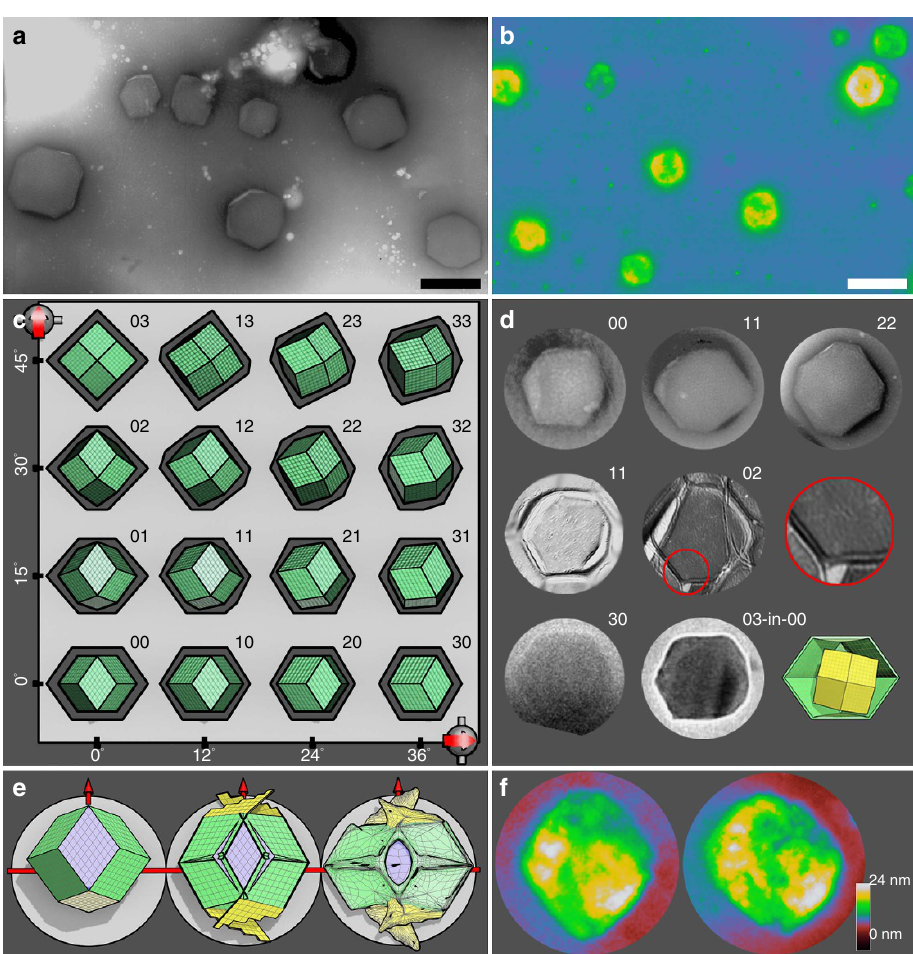
Figure 3 | Morphology of the SDS@2 b -CD polyhedra. ( a ) A TEM picture of the negatively stained polyhedra, scale bar, 1 m m. ( b ) An AFM image of the polyhedra on mica substrate in a dry condition, scale bar, 2 m m. ( c ) A diagram showing the top view and cross-sectional view (along the xy plane, the dark grey polygons) of a rhombic dodecahedron with different orientations. The orientation is indexed to be compared with TEM images. ( d ) Selected TEM pictures corresponding to the rhombic dodecahedral geometry with varied orientations. From top to bottom rows are images by negatively stained TEM, FF-TEM (highlighting a double-shell configuration), and cryo-TEM (featuring a rare, nonconcentric configuration). ( e ) A simple scenario of the collapse of hollow dodecahedra. First, one of the 12 equal faces rather than any vertex will land on a flat substrate, then the 2 faces parallel to the substrate are labelled cyan, the 2 faces perpendicular to the substrate yellow and the other 8 faces green. Second, we consider the dodecahedron to experience a vertical pressure due to gravity and dehydration, then the cyan faces may remain intact, the yellow faces may be forced to fracture, and the green faces squeezed. Finally, the dodecahedron collapses into a somewhat rhombic structure with bumps along the equator, a sink in the center, and pits near two poles. ( f ) Selected AFM images are accounted by the scenario. Please note that the dodecahedra are about 1 m m large so the scale bars for d and f are not